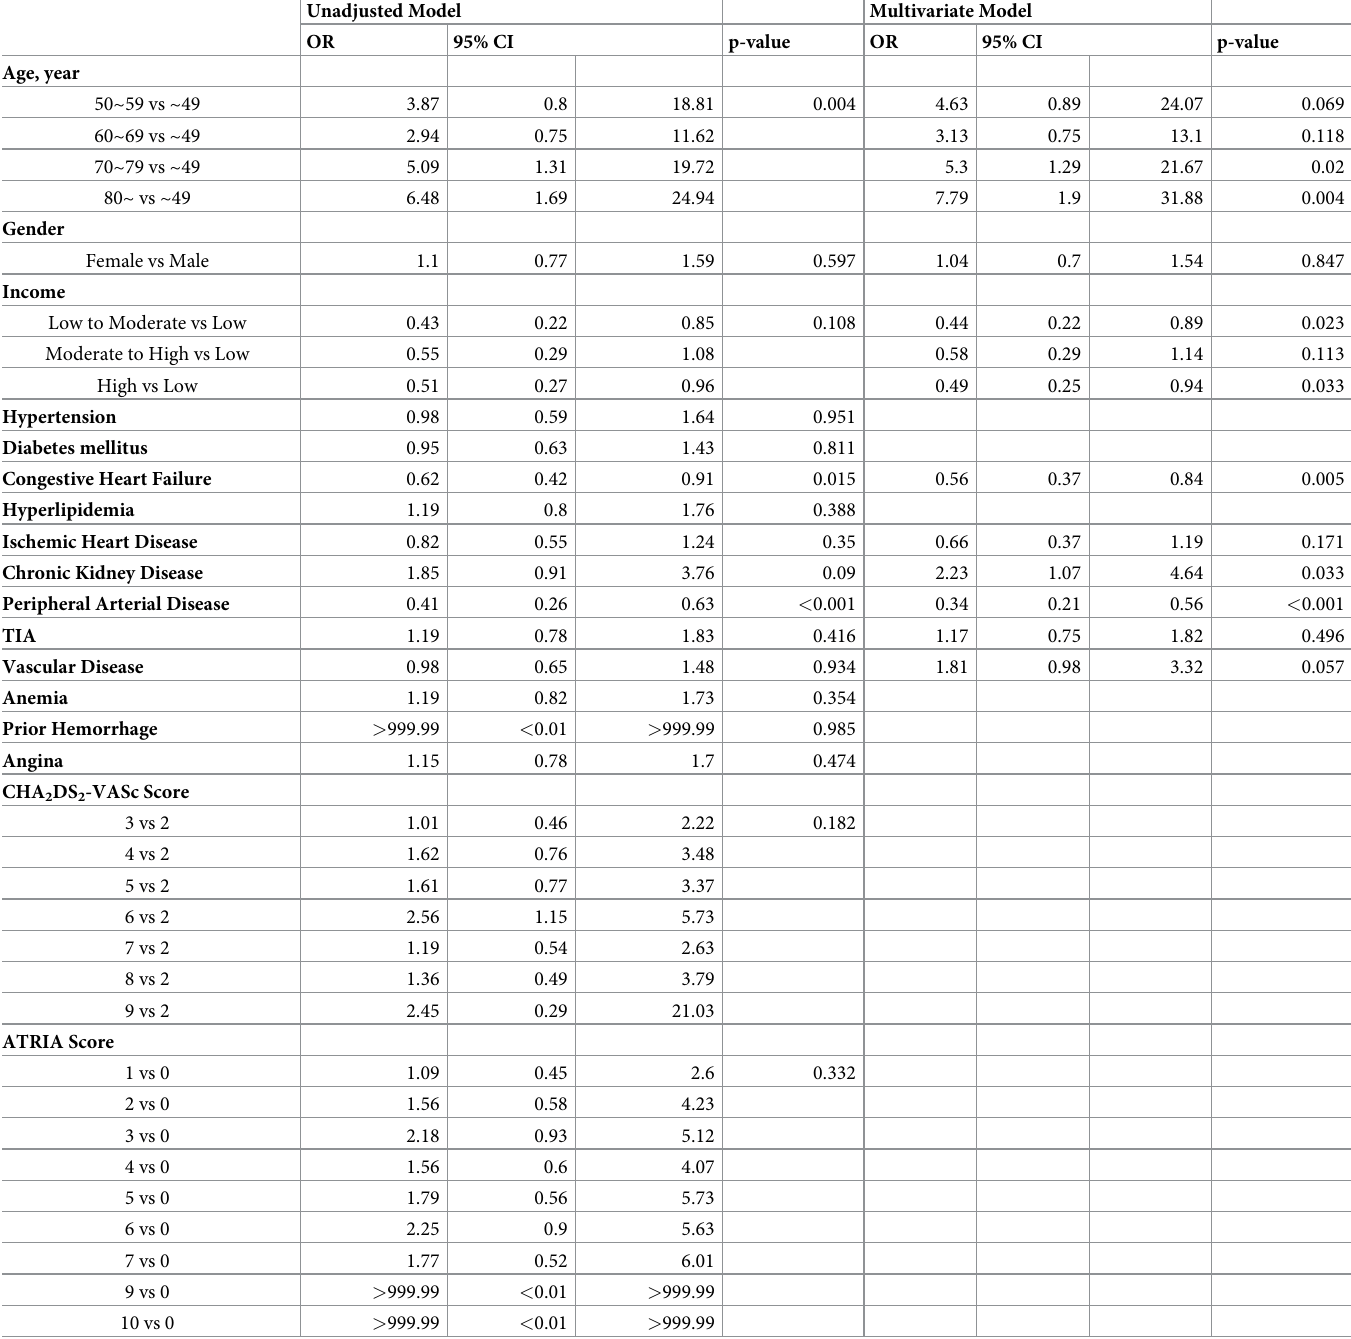
Table 4. Determinants for OAC non-use among patients with OAC candidates � . Unadjusted Model Multivariate